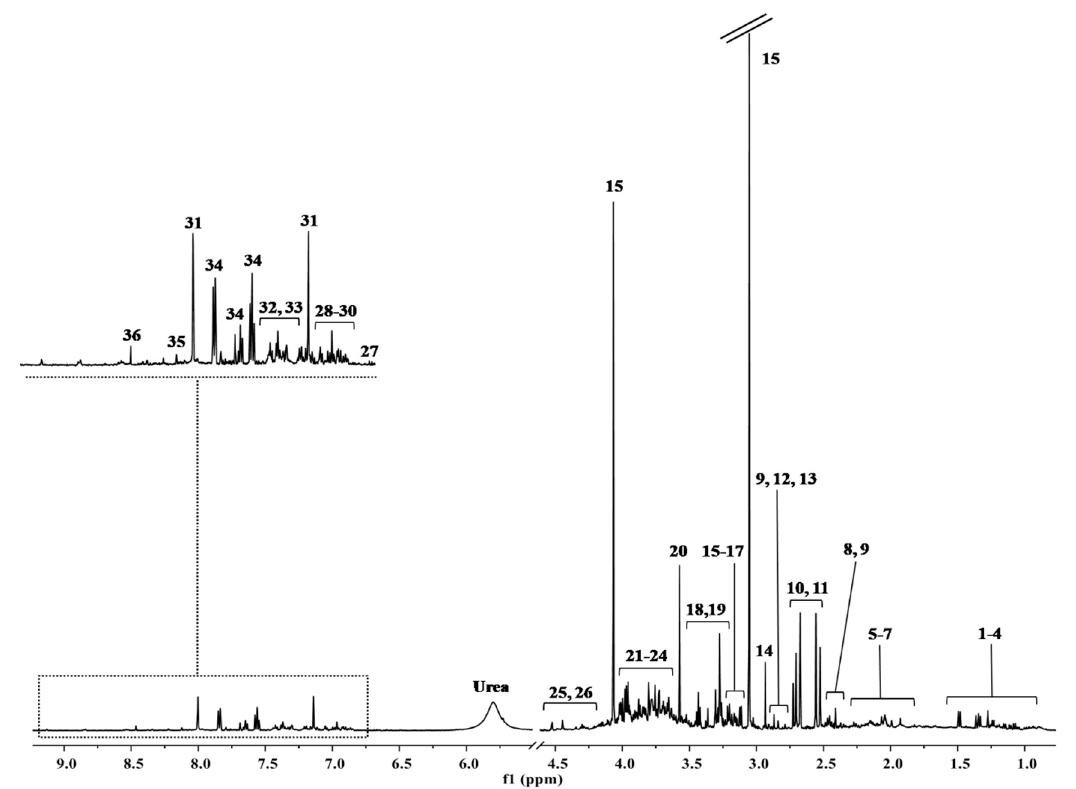
Figure 1. The major spectral area assignments of a representative 1 H-NMR spectra of urine. Metabolites were identified based on literature information and by using a dedicated library, such as the Human Metabolome Database (HMDB, http://www.hmdb.ca, 29 March 2020, date last accessed) and the 500 MHz library from Chenomx NMR suite 7.1. Peaks : (1) 3-methyl-2- oxovalerate, (2) 2-hydroxyvalerate, (3) isoleucine, (4) valine, (5) 2-aminoadipate, (6) homoserine, (7) glutamine, (8) pyruvate,